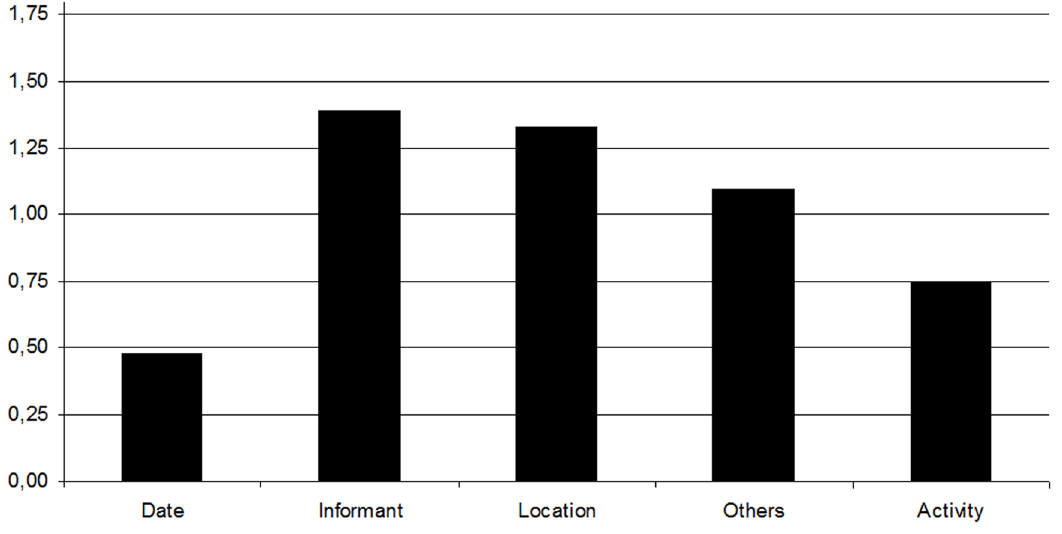
Figure 1. FBM Canonical categories